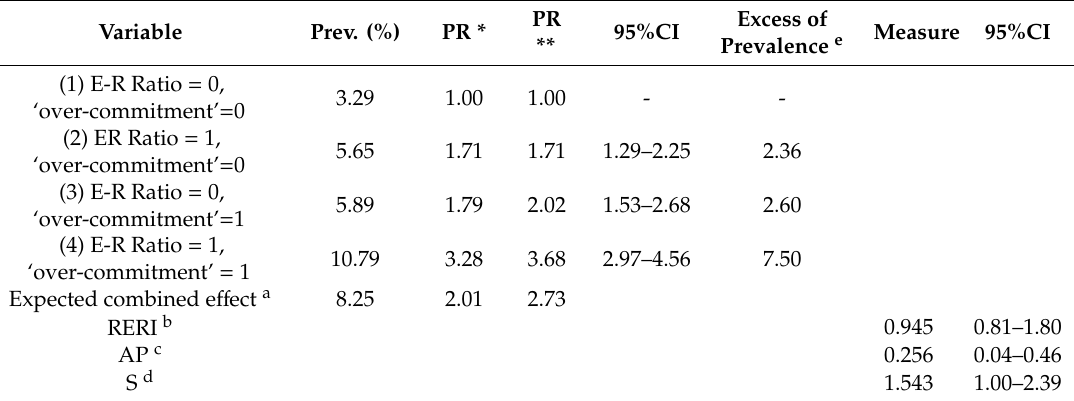
Table 5. Analysis of interaction ER ratio and ‘over-commitment’ based on the additivity criterion. ELSA-Brasil,